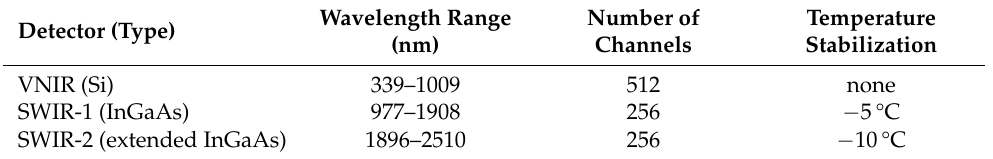
Table 1. Detector arrays of the SVC HR-1024i spectroradiometer applied for radiance transfer